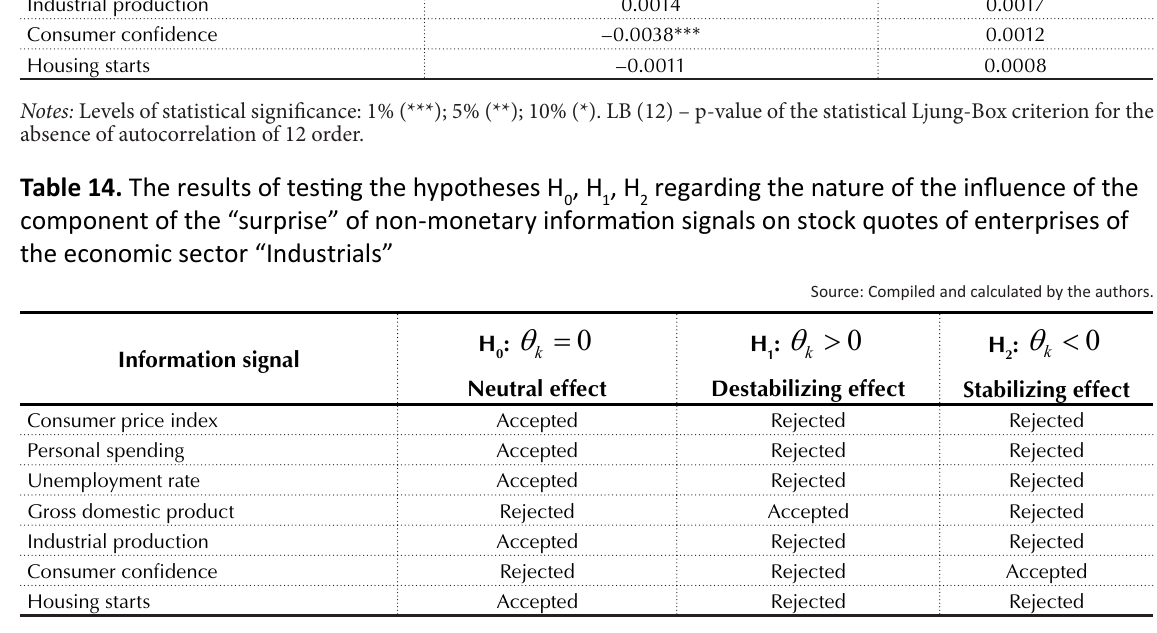
, H , H regarding the nature of the influence of the 0 1 2